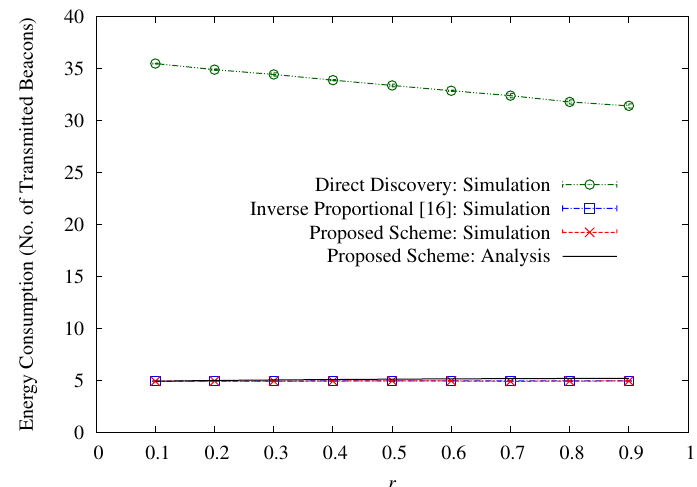
Figure 6. Energy consumption of different